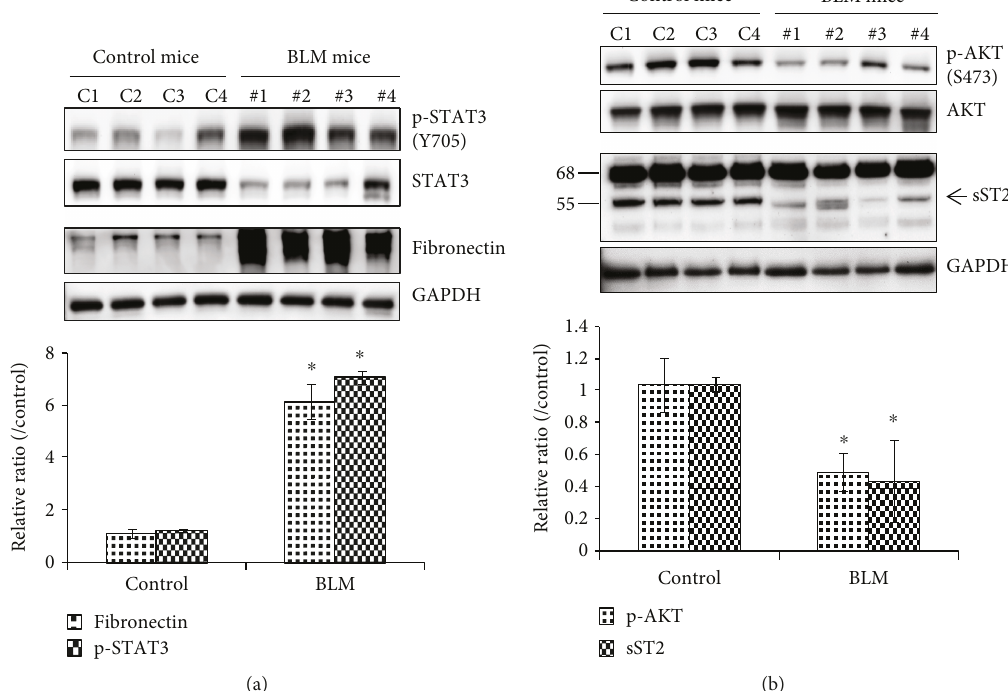
Figure 5: Activation of STAT3 is associated with inactivation of AKT in fi brotic lung tissue. The sliced left lung lobes of mice were homogenized, and the lysate was analyzed by Western blotting. (a) Fibronectin and STAT3. (b) ST2and AKT were detected in lung lysates. The intensity of bands in the Western blots was measured by ImageJ software. GAPDH was used as an internal control. The quantitative data were expressed as the means ± SD . ∗ p < 0 05 compared with